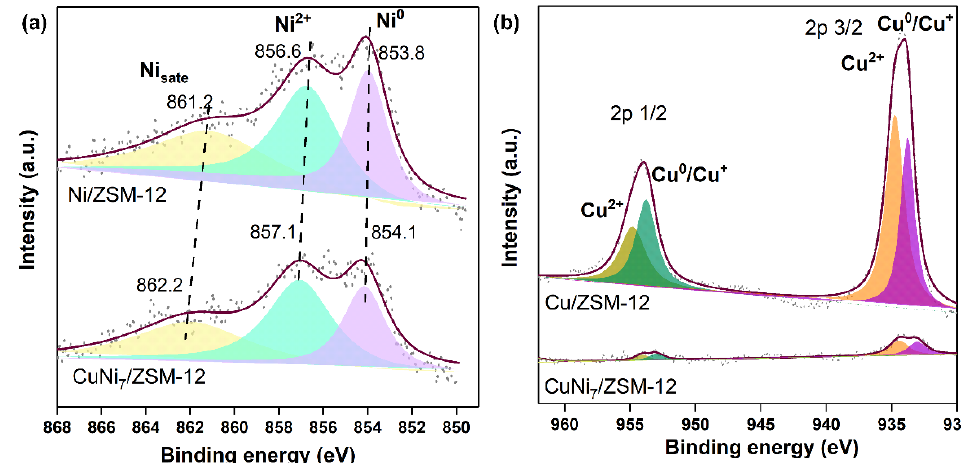
Figure 5. XPS spectra of Ni2p ( a ) of Ni/ZSM-12 and CuNi 7 /ZSM-12 catalysts; Cu2p ( b ) of Cu/ZSM-